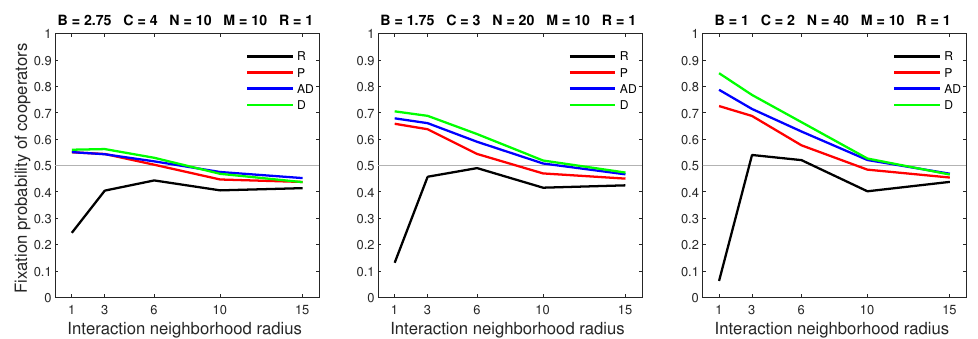
Figure 19. Deterministic dispersal is the highest performing model, followed by the almost deter- ministic model, with probabilistic dispersal producing the lowest fixation probability of out of all success-driven models.